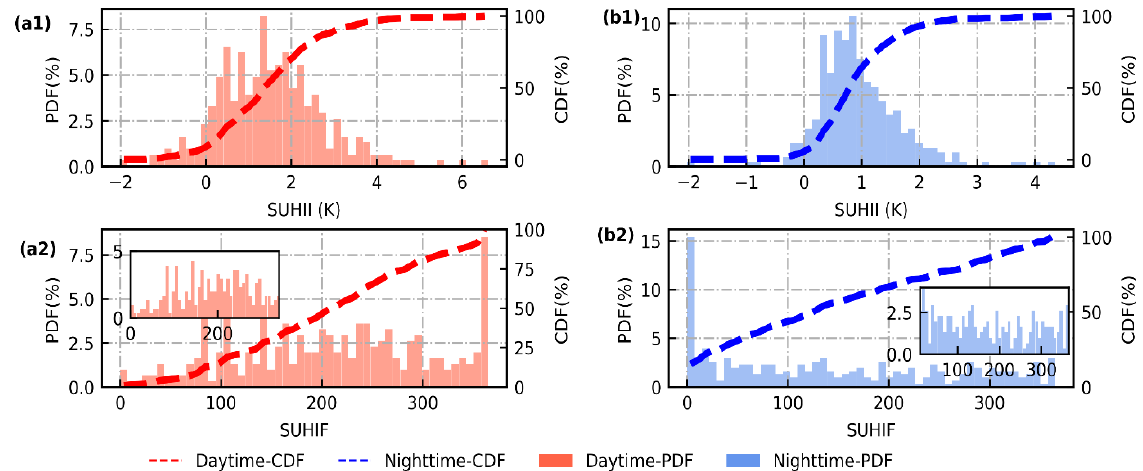
Figure 5. Annual variations of SUHII and SUHIF at daytime ( a ) and nighttime ( b ). The plots in the first row show the value distribution of annual SUHII ( a1 , b1 ), and the second-row plots show that of SUHIF ( a2 , b2 ). PDF and CDF are employed to show the value distribution across the selected cities. To clearly show their variations, zoom-in images without the extremum are added for SUHIF.